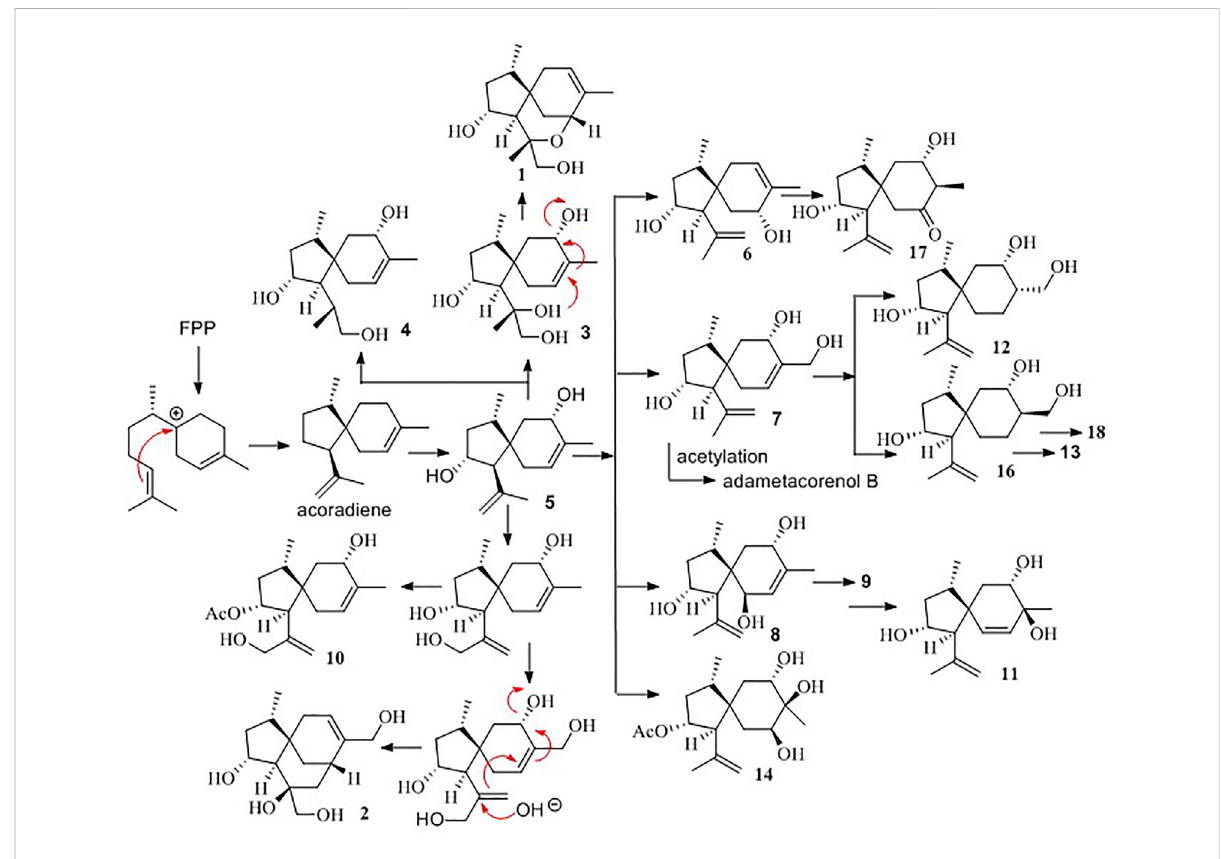
SCHEME 1 Biogenetic relationships of